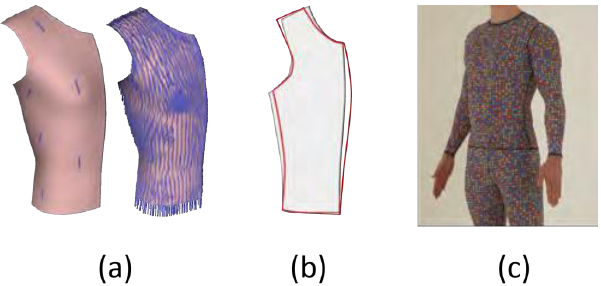
Fig. 12 The user defines the desired compression-directions on the surface (a). The pattern is flattened (b, red contour) by retaining the desired compression value along the given direction. The traditional garment shrinkage process (scaling in the 2D pattern domain) is also shown (b, gray pattern). The sewn garment with the desired compression is shown in